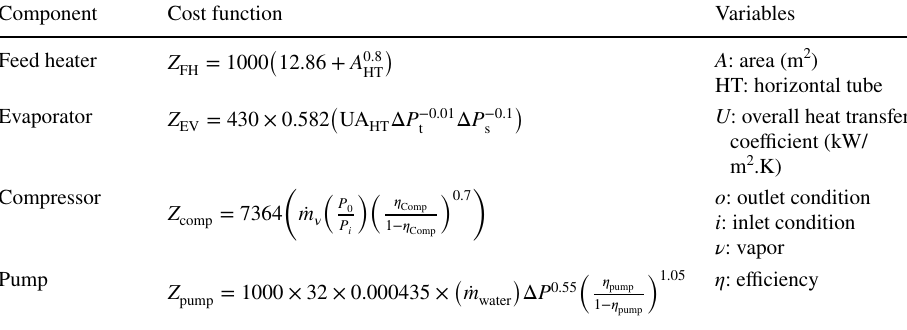
Table 11 Capital costs for facilities in the desalination system (Jamil and Zubair 2017; El-Mudir et al.